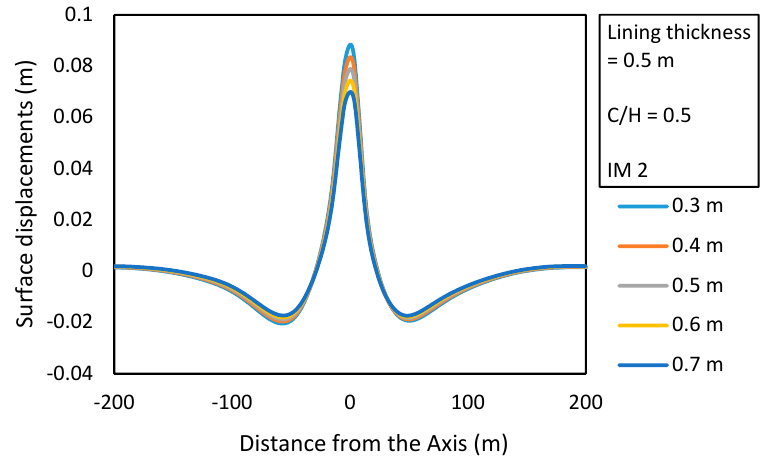
Figure 5. Effect of variation in the thickness of the internal structure on the surface settlements.